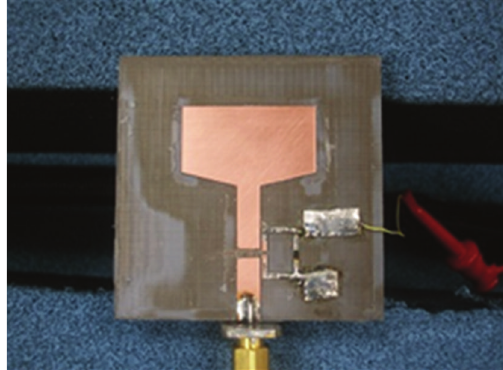
Figure 10: A fabricated prototype of the proposed tunable filter- antenna.